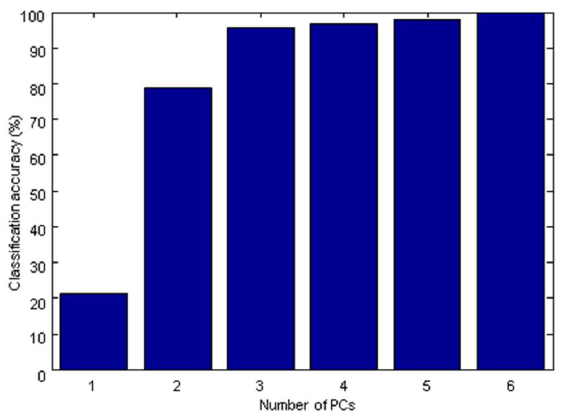
Figure 7. Classification accuracy of the SVM-DA model according to number of PCs.